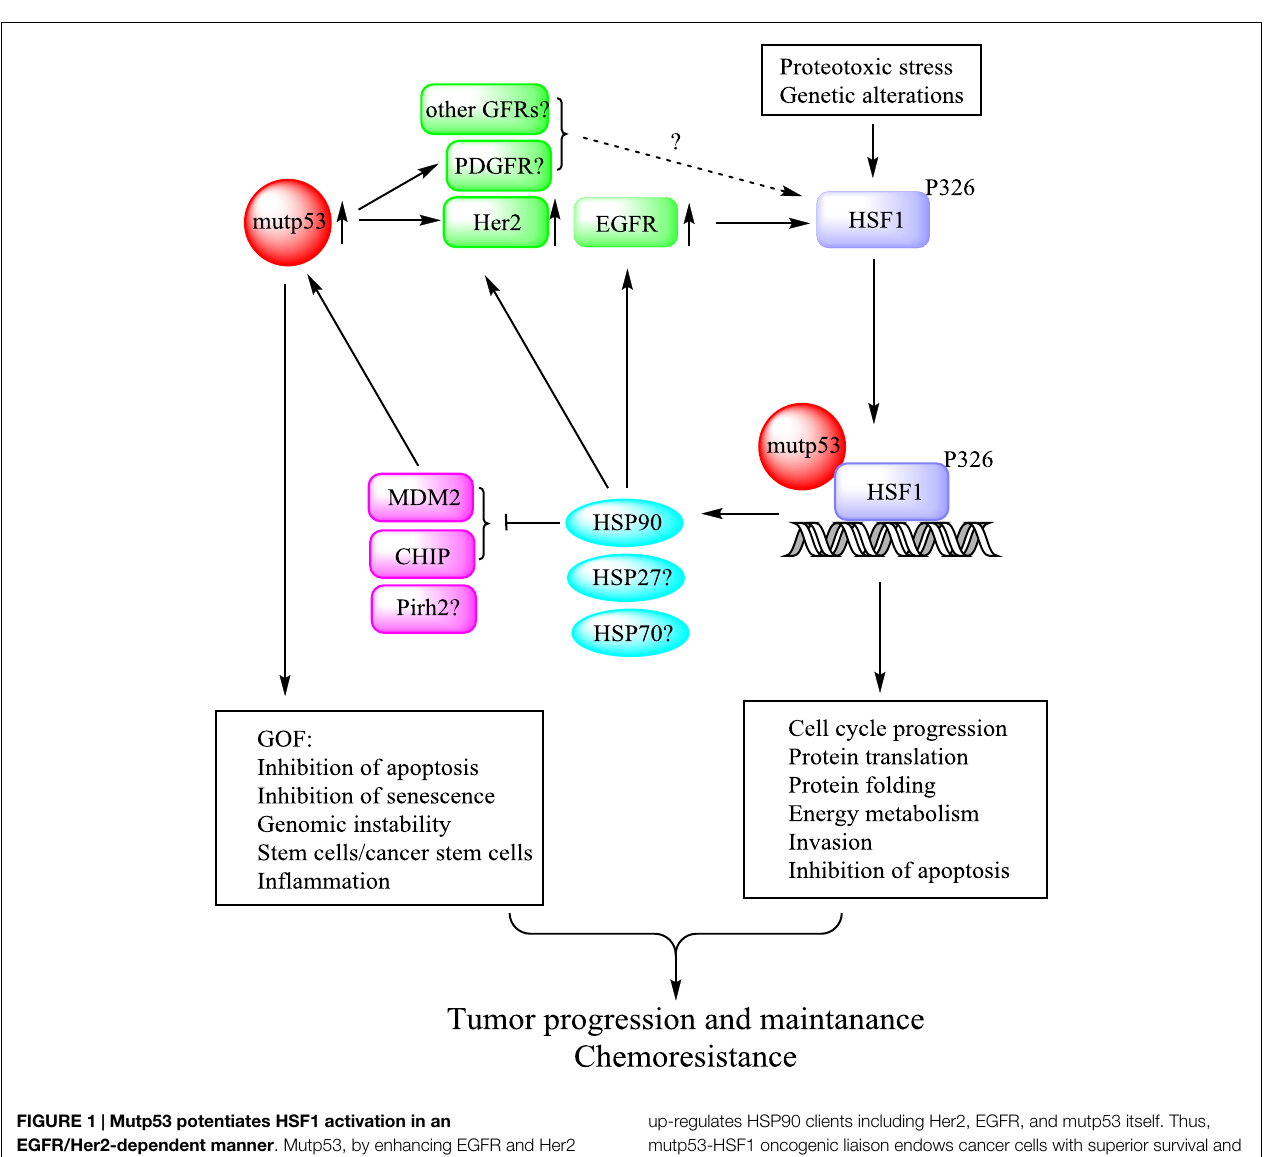
FIGURE 1 | Mutp53 potentiates HSF1 activation in an EGFR/Her2-dependent manner . Mutp53, by enhancing EGFR and Her2 signaling, potentiates HSF1 activity via a feed-forward loop and thereby